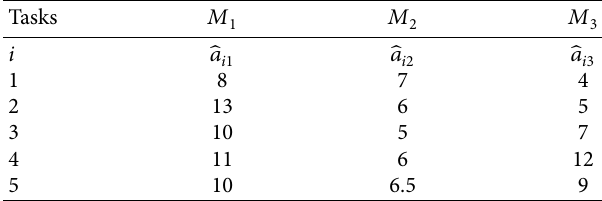
Table 7: PQFN processing times with crisp format.